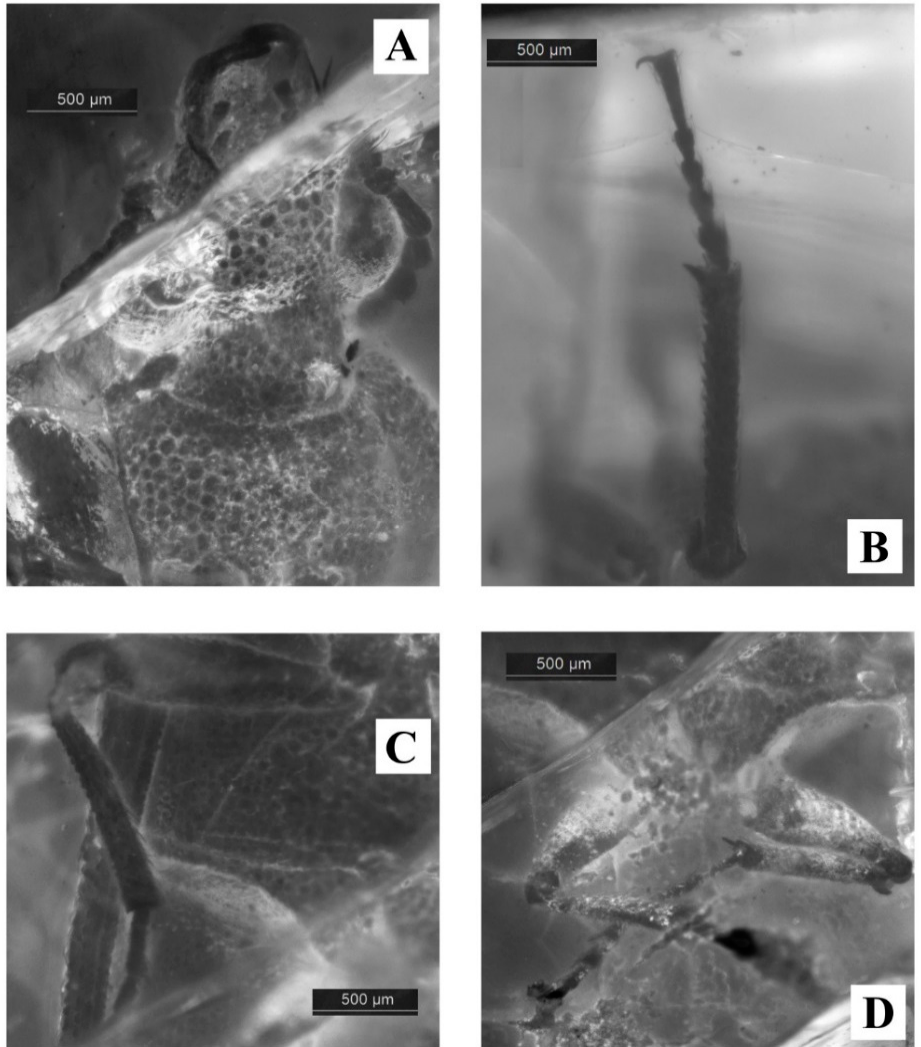
Figure 14. Ommatinae (Cupedidae): Omma janetae sp. nov. , holotype ZIN Cuped 004 (Lower/Upper Cretaceous: Upper Albian / Lower Cenomanian; Myanmar, Kachin, Burmese amber); fluorescent microscopy with filter set N21: A —head and prothorax, dorsal, B —protibia and protarsus, lateral, C —intermediate leg and metacoxa, ventral, D —metacoxae and posterior legs, ventral; length of inclusion 8.6 mm; scale for each picture provided; original.